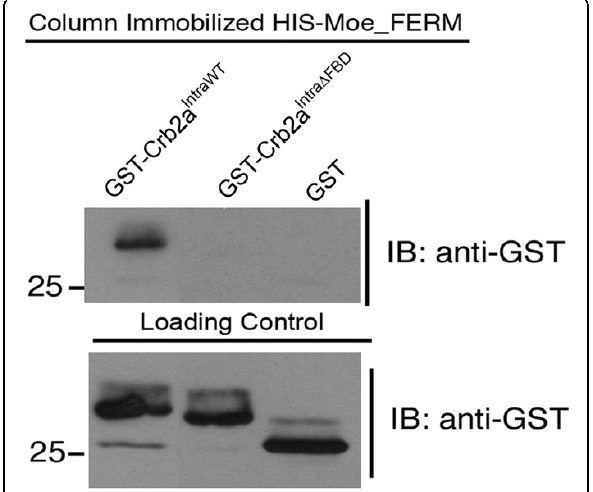
Figure 3 The FBD mutations Crb2a abolish binding to the FERM protein Moe . In vitro GST interaction between HIS- Moe_FERM immobilized on the column with GST-Crb2a IntraWT and GST-Crb2a Intra Δ FBD . Loading control showing 1/40 input blotted and labeled with